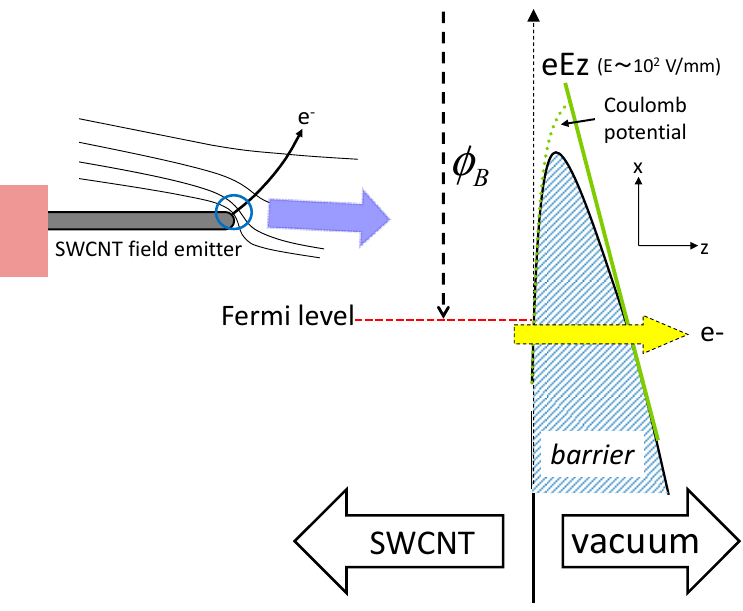
Figure 3. Primitive model of the FE using an SWCNT emitter based on Fowler–Nordheim tunneling.